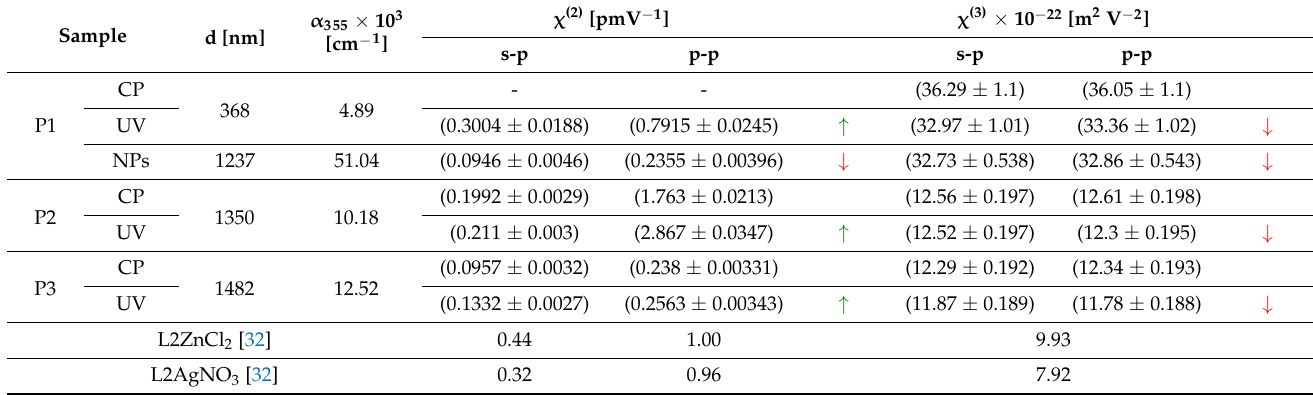
Figure 4. Normalized absorption spectra of studied polymeric thin films. Table 2. Values of thickness (d), absorption coefficient ( α ) at a wavelength of 355 nm, second ( χ (2) ) and third order ( χ (3) ) nonlinear susceptibilities in s-polarized and p-polarized laser beam after corona poling (CP), UV-irradiation (UV), and with ZnO nanoparticles (NPs) calculated for polymers P1, P2, and P3. Green arrows define increasing of χ (2) and χ (3) values, red arrows—decreasing of χ (2) and χ (3)